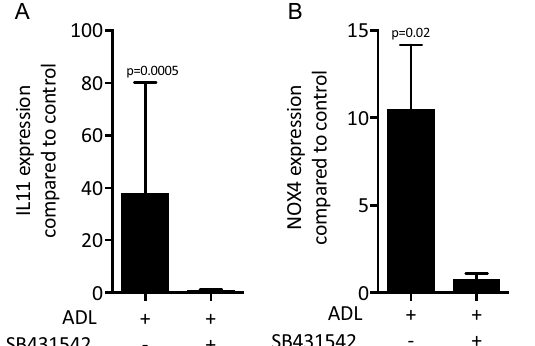
Figure 5. ADL changes the expression of IL11 and NOX4 via TGF-β receptor 1 kinase signaling. Addition of TGF-β receptor 1 kinase antagonist SB431542 to ADL blocks the expression of ( A ) IL11 and ( B ) NOX4. N = 3–5. Data represent the mean ± SD. Statistic was based on two-tailed Mann–Whitney test.